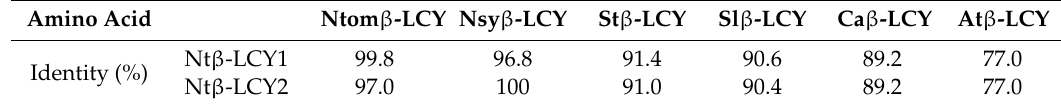
Figure 2. Phylogenetic analysis of the β -LCY genes in higher plants based on an alignment of the nucleotide sequences using MEGA5 software by the neighbor joining method. The bootstrap values were each estimated using 1000 replications. Table 2. Sequence identities of the deduced Nt β -LCY proteins with those of other plants. Amino